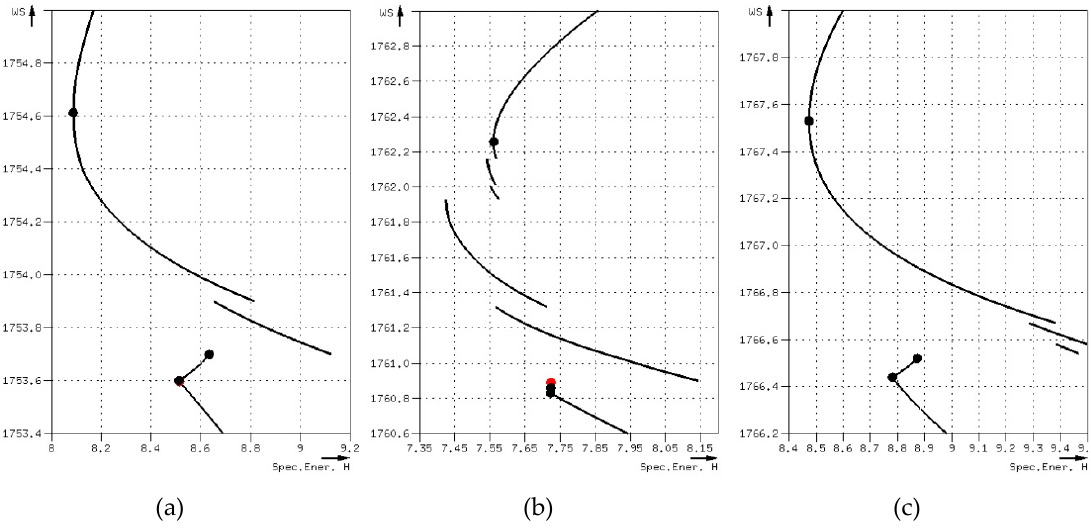
Figure 18 . Dataset 4: Critical depths of case 3 ( a ) section 1, ( b ) section 9 and ( c ) section 14